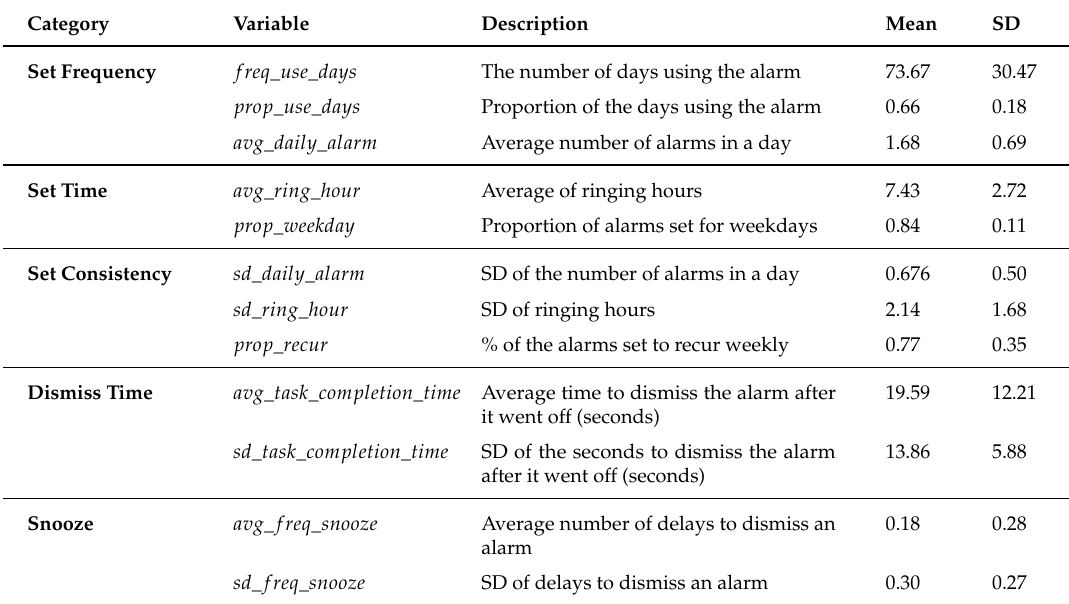
Table 1. Alarm usage